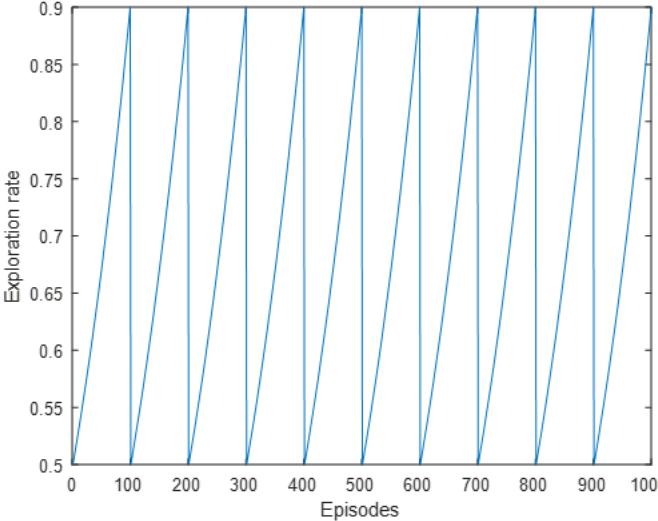
Figure 14. Learning rate plotted over episodes.